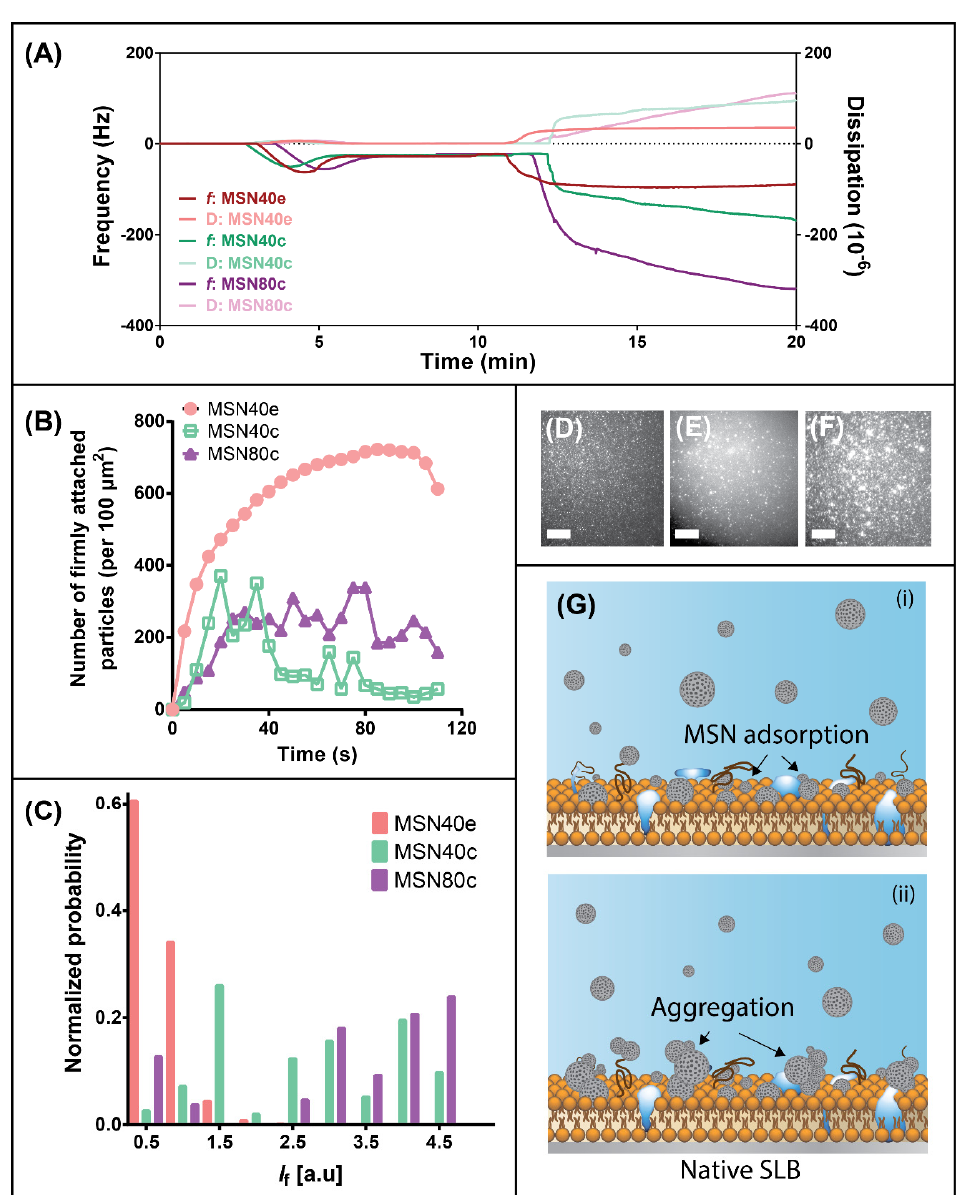
Figure 3. ( a ) Frequency (dark curves; right axis) and dissipation (light curves; left axis) profiles for adsorption of MSN40e (red curves), MSN40c (green curves) and MSN80c (purple curves) onto a supported lipid bilayer (SLB), using quartz crystal microbalance with dissipation (QCM-D). ( b ) The time-dependent change in the number of counted MSN particles firmly adsorbed onto a semi-native SLB for MSN40e (red circles), MSN40c (green empty squares) and MSN80c (purple triangles). ( c ) The normalized mean fluorescence ( I f ) of MSN particles/aggregates adsorbed onto a semi-native SLB after 2 min for MSN40e (red bars), MSN40c (green bars) and MSN80c (purple bars). Representative total internal reflection fluorescence (TIRF) micrographs for ( d ) MSN40e, ( e ) MSN40c and ( f ) MSN80c after 2 min adsorption onto a semi-native SLB. Scale bars = 10 µm. ( g ) Schematic representation of the (i) adsorption and (ii) aggregation mechanism of MSNc particles on a semi-native SLB. The formation of a snSLB was first achieved by depositing semi-native membrane vesicles, labelled with a fraction of tracer vesicles containing NBD-PE (1 mol%), onto a smooth, hydrophilic